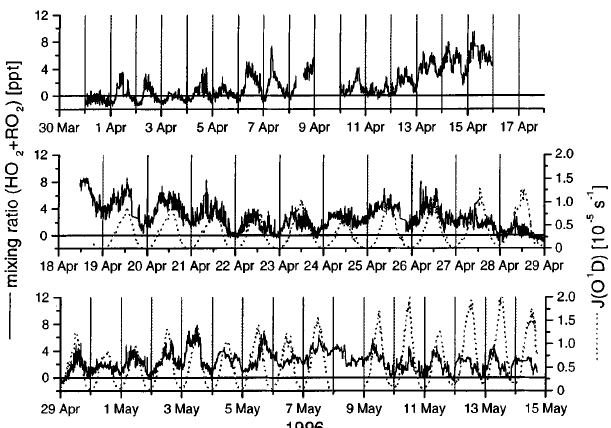
Fig. 11. BrO mixing ratio as function of O 3 mixing ratio, main ozone depletion